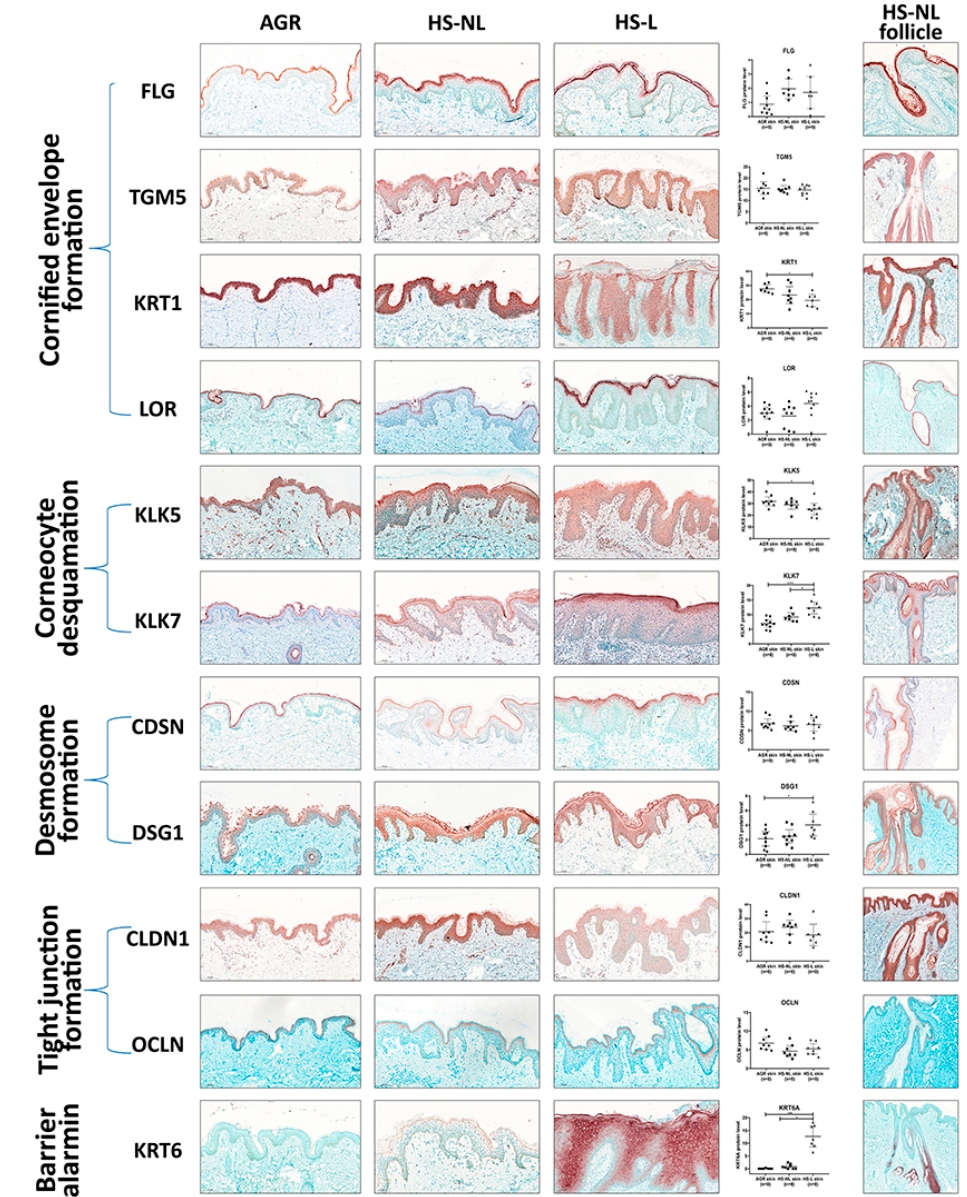
Figure 2. Representative images for immunostaining and epidermal quantification of SC and cell junction components in healthy AGR, non-lesional HS and lesional HS skin samples. Protein levels were blindly analyzed by Pannoramic Viewer software. In the last column, representative images for the follicular epidermal pattern of permeability barrier components in non-lesional HS skin samples were demonstrated. Size bars = 100 µm. The graphs show the median ±95% confidence interval of measured protein levels (* p < 0.05; ** p < 0.01; *** p < 0.001, as determined by one-way analysis of variance followed by Sidak’s post hoc test in case of normal distribution or Kruskal–Wallis test followed by Dunn’s post hoc test when data distribution was not normal). Abbreviations: AGR, apocrine gland rich; CDSN, corneodesmosin; CLDN, claudin; DSG1, desmoglein 1; FLG, filaggrin; HS, Hidradenitis suppurativa; HS-L, HS lesional skin; HS-NL, HS non-lesional skin; KLK, kallikrein-related peptidase; KRT, keratin; LOR, loricrin; OCLN, occludin; TGM, transglutaminase.